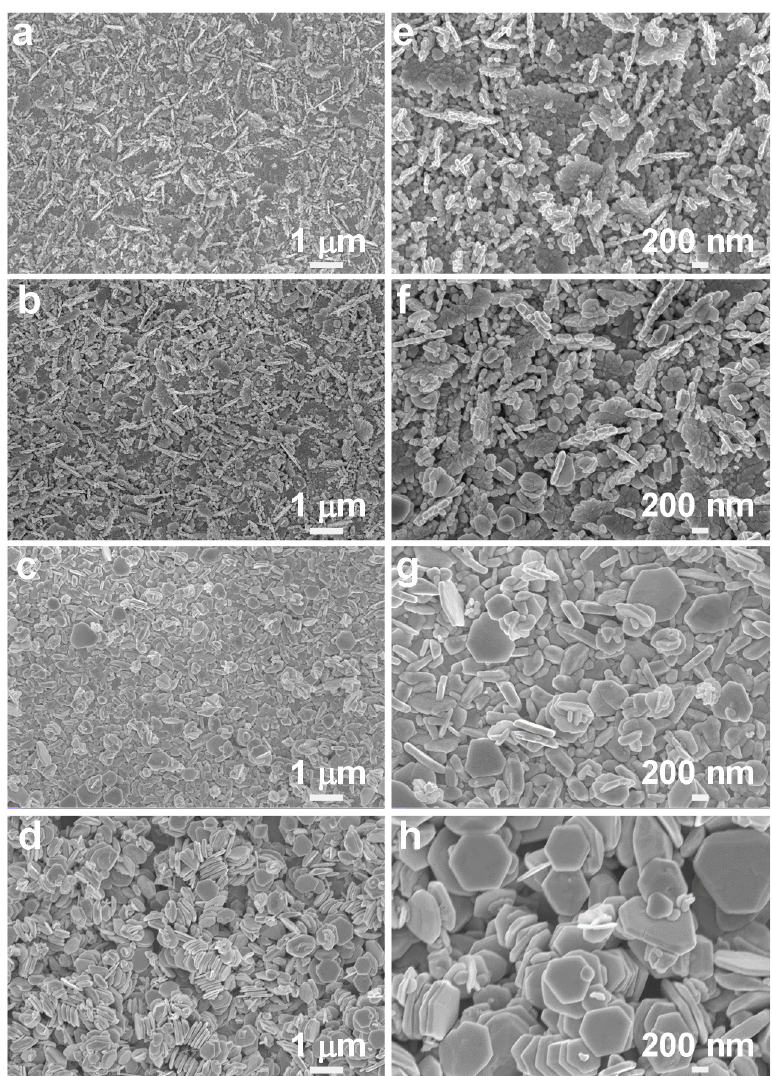
Figure 2. Low- and high-magnification SEM images of silver nanoaggregates prepared at irradiation intensities of ( a , e ) 1.5 × 10 5 W/cm 2 , ( b , f ) 4.5 × 10 5 W/cm 2 , ( c , g ) 8.0 × 10 5 W/cm 2 , and ( d , h ) 1.2 × 10 6 W/cm 2 , respectively, at a fixed irradiation time of 25 min.